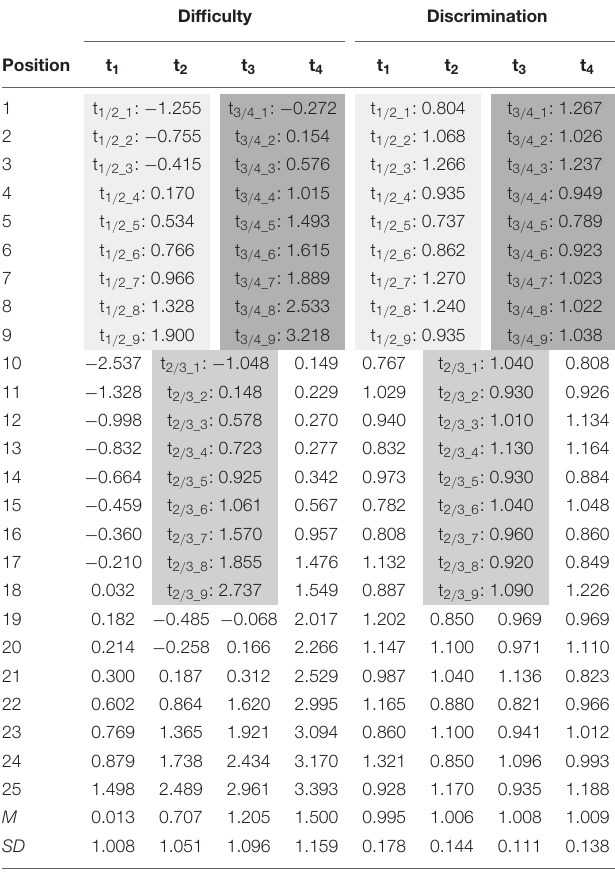
Framed parameters represent anchor items linking adjacent measurement points. Position = item position in each test form; t 1 / 2 , t 2 / 3 , t 3 / 4 = true anchor item parameters linking measurement points t 1 , t 2 , t 3 , t 4 ; M = mean of 25 true item parameters; SD = standard deviation of 25 true item